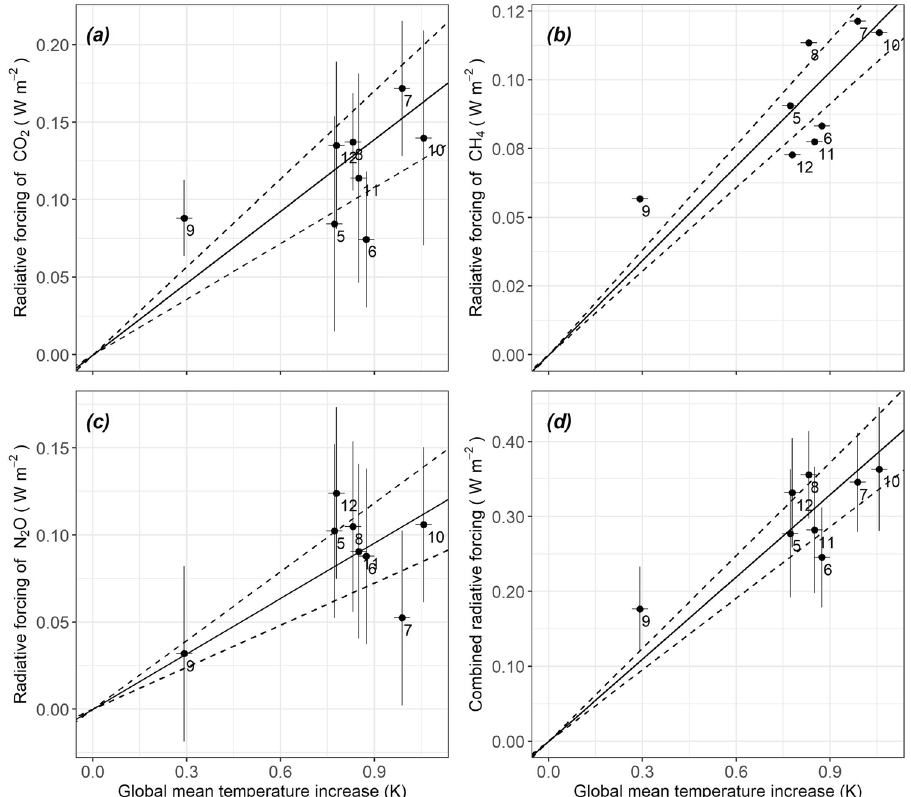
Fig. 3 Maximum likelihood estimation of feedback strengths. The fi gure shows the relationship between the increase in global mean temperature and radiative forcing induced by changes in ( a ) CO 2 , ( b ) CH 4 , ( c ) N 2 O concentrations and ( d ) combined radiative forcing of CO 2 , CH 4 and N 2 O. Each D-O event is numbered; the horizontal and vertical lines show the 95 % con fi dence intervals. The measurements of CH 4 concentration are very accurate so the vertical lines are too small to be observable on these plots. The solid line shows the maximum likelihood estimation of the ratio of radiative forcing to global mean temperature increase, the dashed lines show the 95 % con fi dence intervals of the